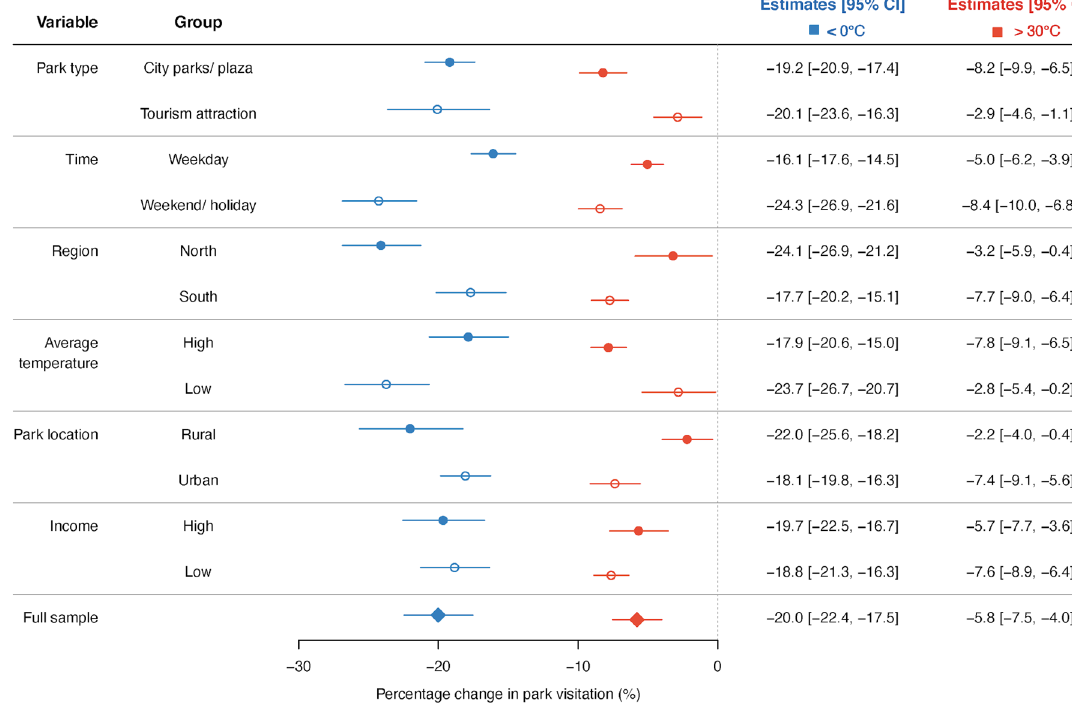
Figure 2. Heterogeneous effects of hourly temperature on park visitation quantity. Dots are point estimates when applying Eq. (1) yet merging the bins above 30 °C and below 0 °C. Error bars are 95% confidence intervals. Detailed heterogeneity analysis by temperature bins is summarized in Supplementary Fig. 2 and the numerical estimates are presented in Supplementary Table 5.